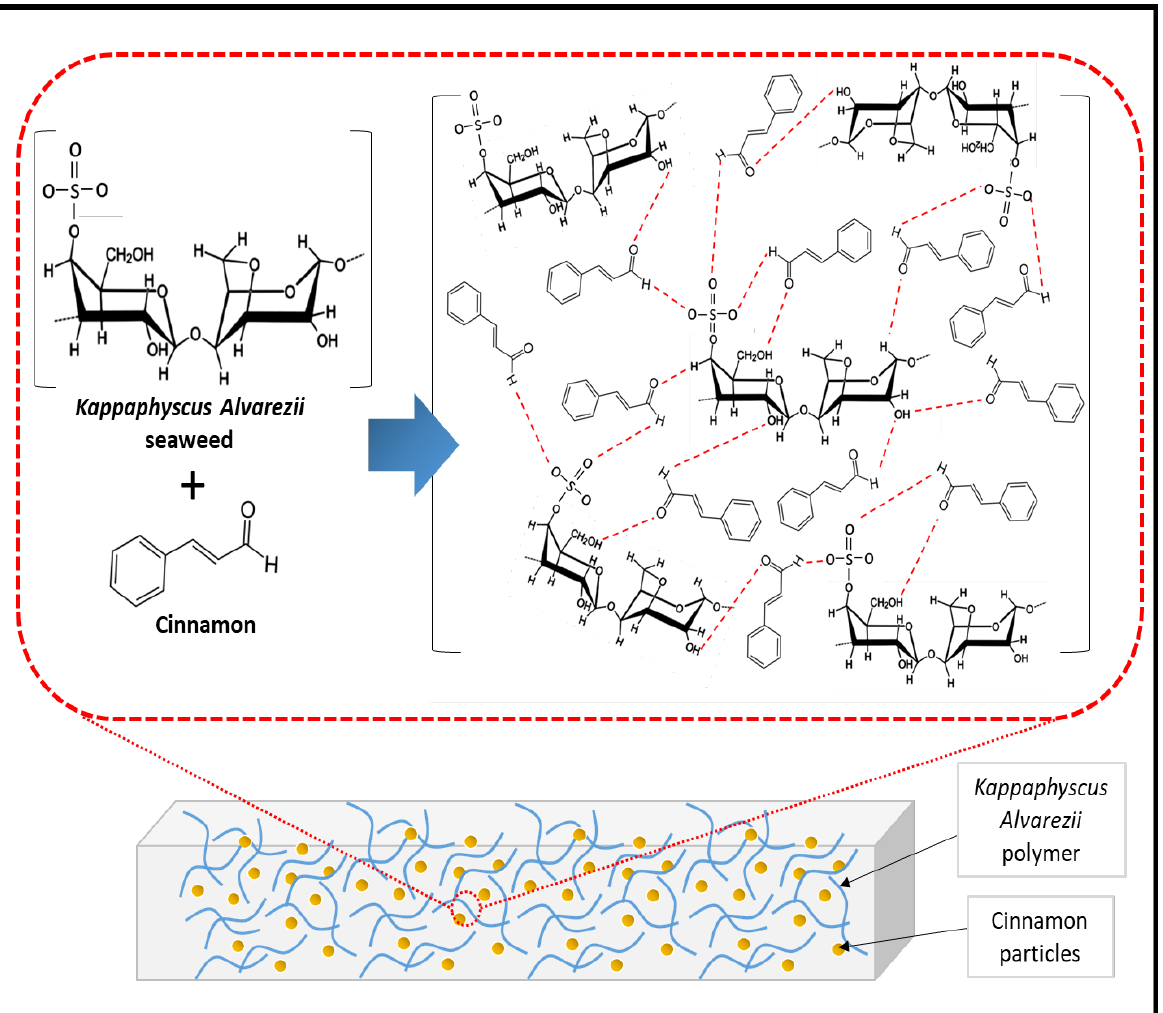
Figure 4. Possible mechanism (hydrogen bonding) of cinnamon incorporated with Kappaphyscus Alvarezii biopolymer.